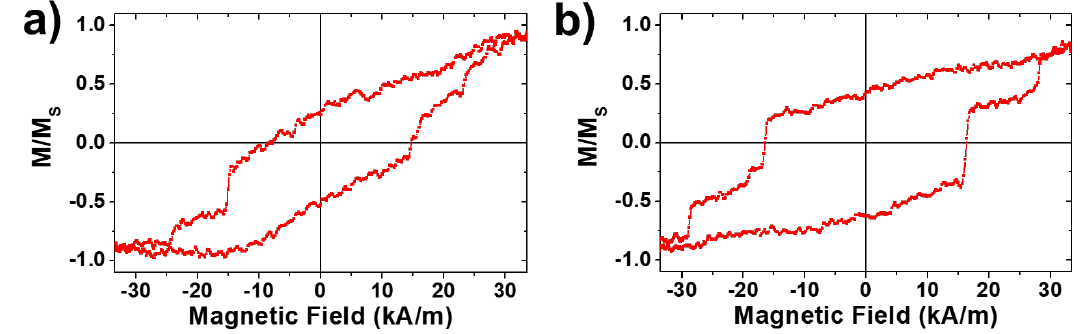
Figure 5. MOKE hysteresis loops of single, isolated and bi-segmented FeNi nanowires with diameter modulation, measured at the narrow/wide segments interface. ( a ) corresponds to sample WM9, while ( b ) was obtained for sample WM2.